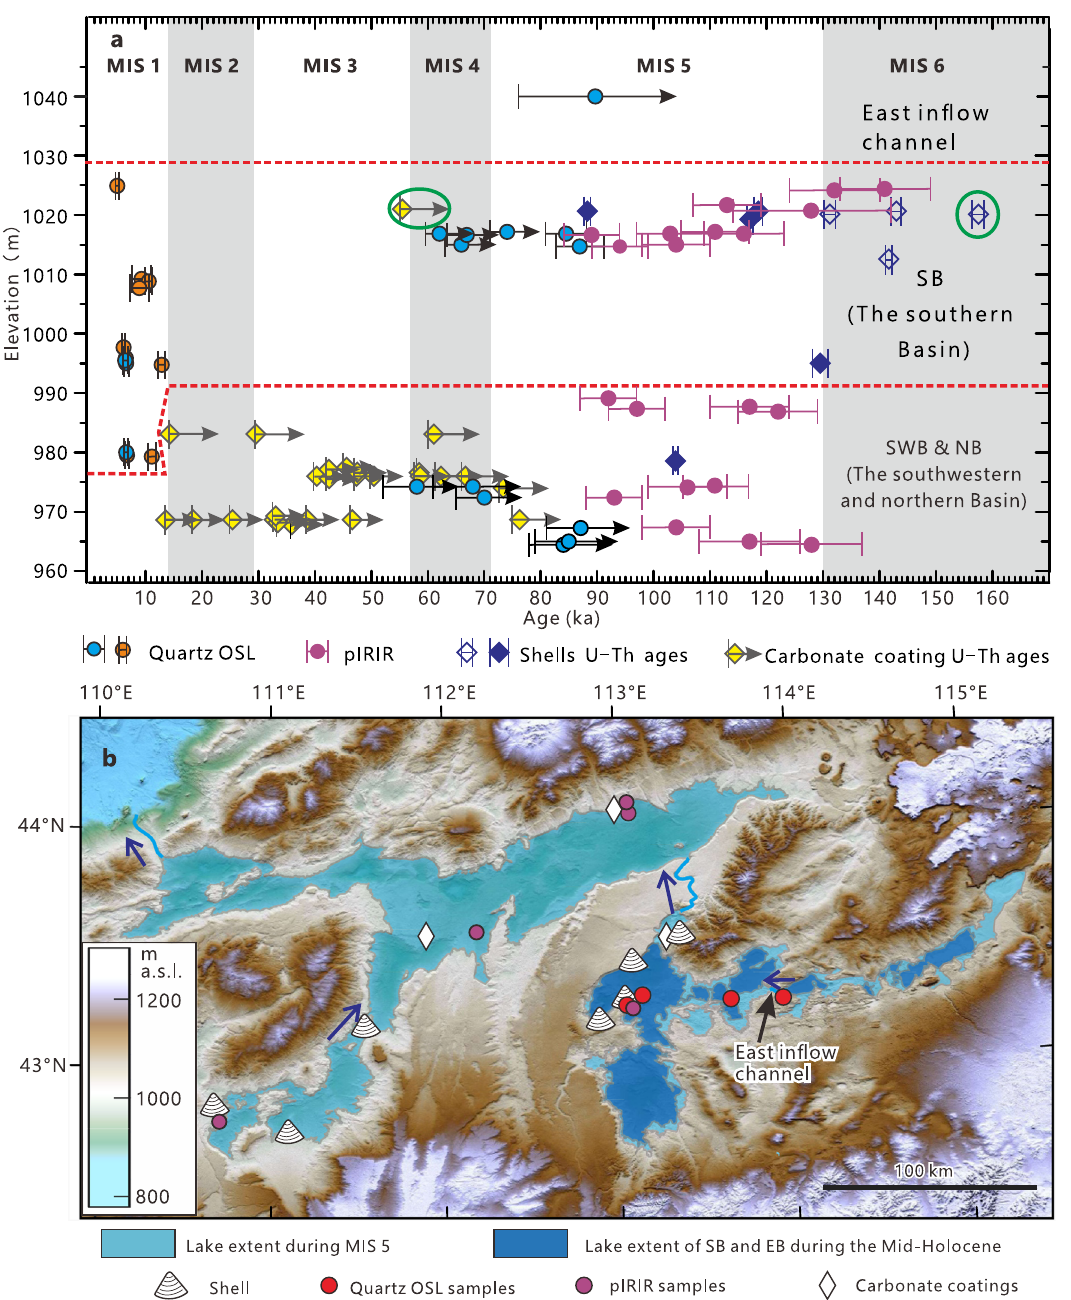
Fig. 4 | Chronology and extent of MIS 5 and mid-Holocene paleolakes. a Paleolake age estimated by different dating methods. The blue/purple circles showthequartz(OSL)/K-feldspar(post-infra-redinfraredstimulatedluminescence, pIRIR) luminescence ages of shoreline deposits in the SB and NB, with the 1-sigma uncertainty represented by the vertical bars; quartz OSL ages for aeolian deposits fromshorelinesarerepresentedbyorangecircles (SupplementaryTables 3and 4). The arrows to the right of the blue circle indicate that these quartz OSL dates are considered to be minimum ages because D e values ≥ 150Gy are measured. Dark